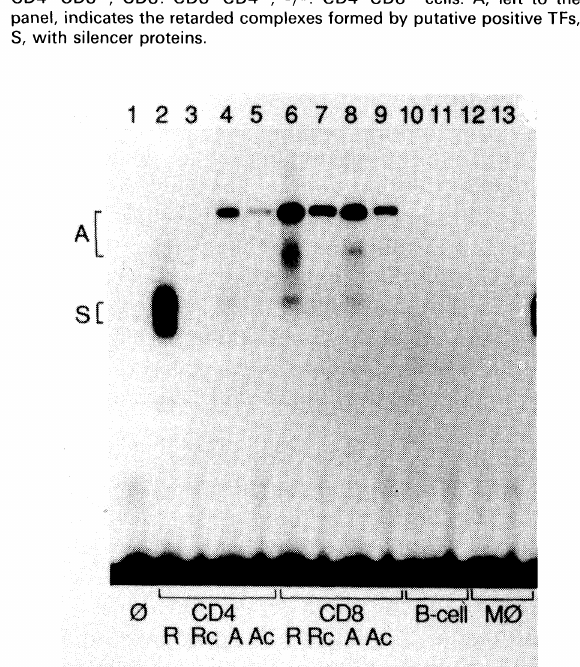
FIG. 3. Specificity of TFs present in T-cell subsets. The same proteins as in Fig. 2 were used. In addition, extracts of B-cells and monocytes (M,) from two independent donors were tested. Specificity of binding was verified by competition with a 20-fold excess of cold Pud DNA (Ac, Rc). Numbers on top of each plate refer to lanes commented in the